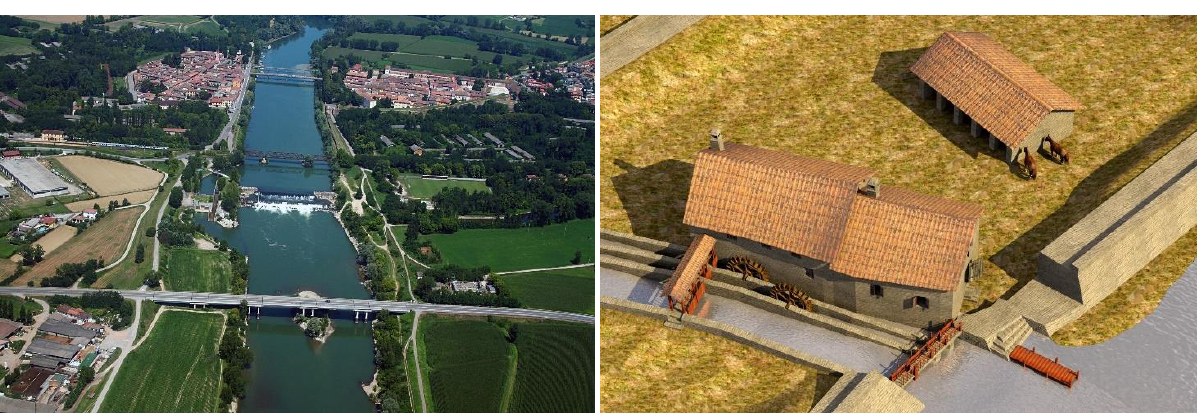
Figure 1. Left: aerial view of the site on the Adda river. Right: virtual reconstruction of the watermill on the left bank of Adda